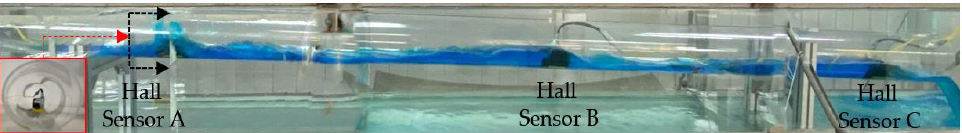
Figure 2. Human-machine interface of subsea pipeline detection system.